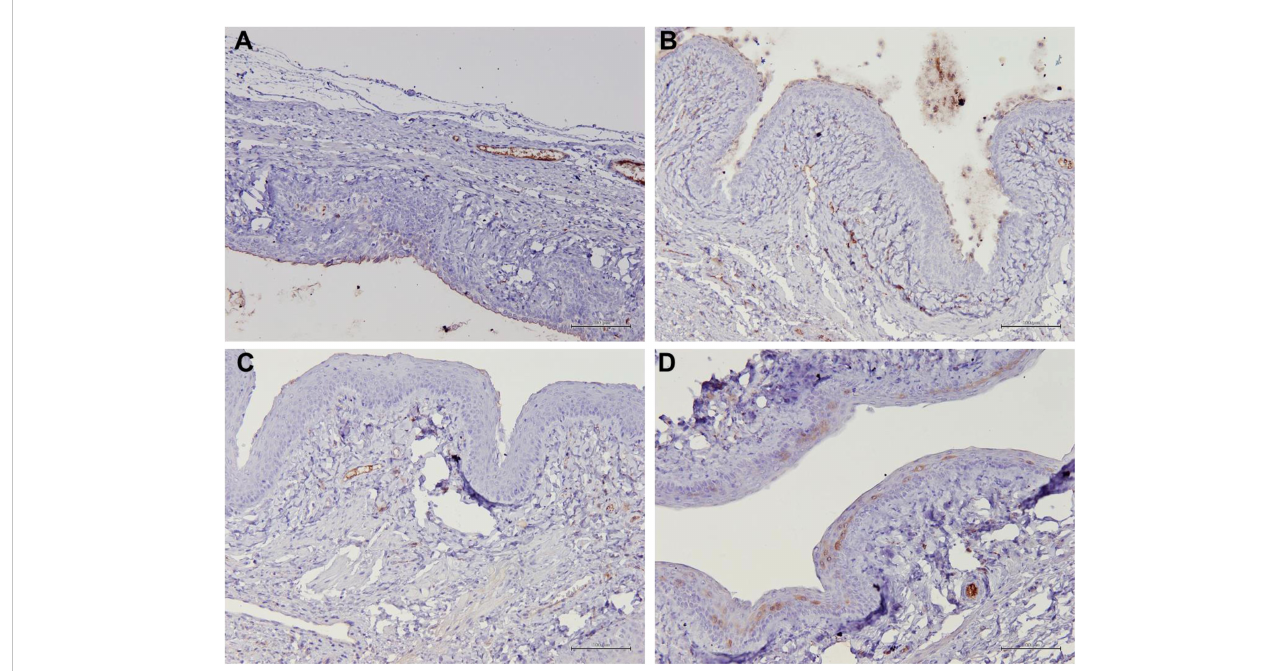
FIGURE 7 Structure of the rat vaginal epithelium and Muc1 protein localization in the rat vaginal tissue following a two-week administration of Gelam honey at 0.2 g Gelam honey/kg bw/day doses. (A) Gelam honey and bilateral oophorectomized group (Gelam honey +Ovx), (B) Estrogen replacement therapy and bilateral oophorectomized group (ERT+Ovx), (C) Bilateral oophorectomized group (Ovx) and (D) Sham group (SC). The tissues were stained with DAB/ HRP stain for protein localization (in brown) and counterstained with H&E for nuclear staining. All measurement bars are equivalent to 100